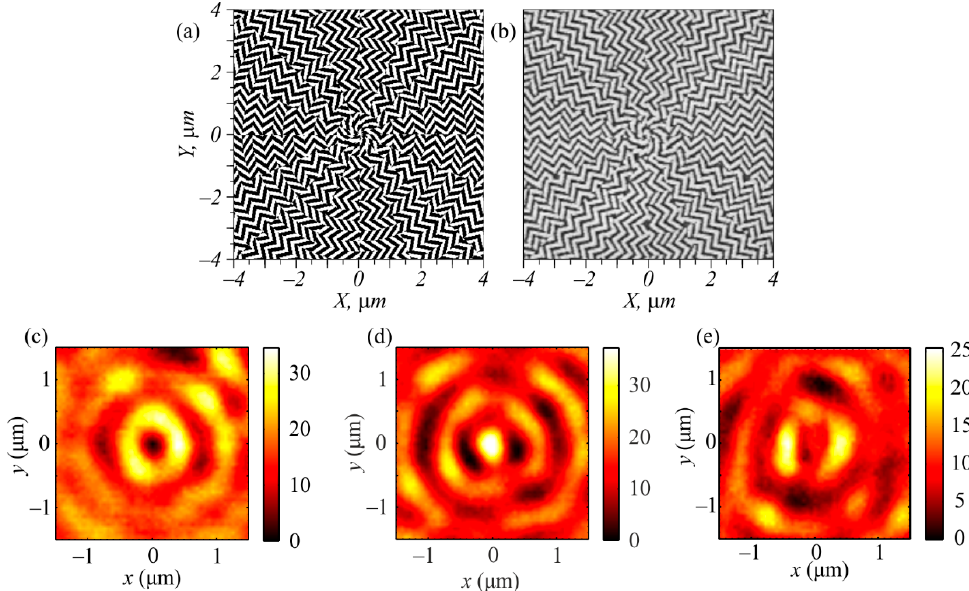
Figure 7. Binary photo template of metalens (14) ( a ); central part of the metalens fabricated in an amorphous silicon film ( b ); intensity distribution in the focus of the metalens when it was illuminated by an optical vortex with a topological charge of +1 and with different polarizations: left circular ( c ), right circular ( d ), and linear (along the horizontal axis) ( e ).